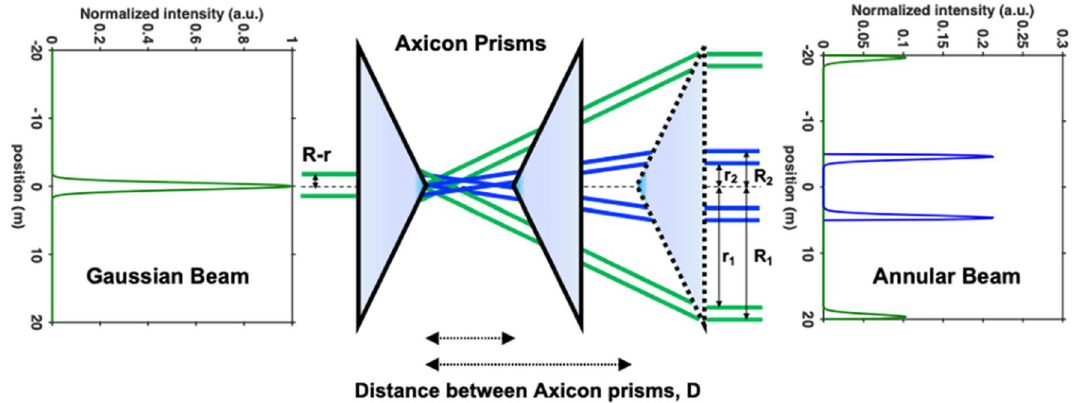
Figure 1. Transformation from the Gaussian beam to the annular beam with different diameters using a pair of Axicon prisms. The left and right-side graphs show the intensity distributions of Gaussian beam and annular beams with diameters 10 mm (blue) and 40 mm (green),